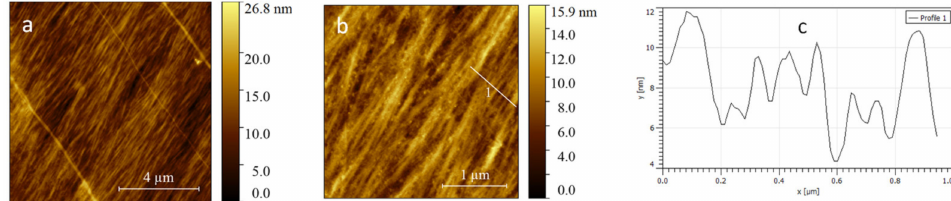
Figure 5. AFM images of G4–CD_3: ( a ) scale bar–4 µ m; ( b ) scale bar–1 µ m; and ( c ) Z–profiles along the lines marked on the image ( b